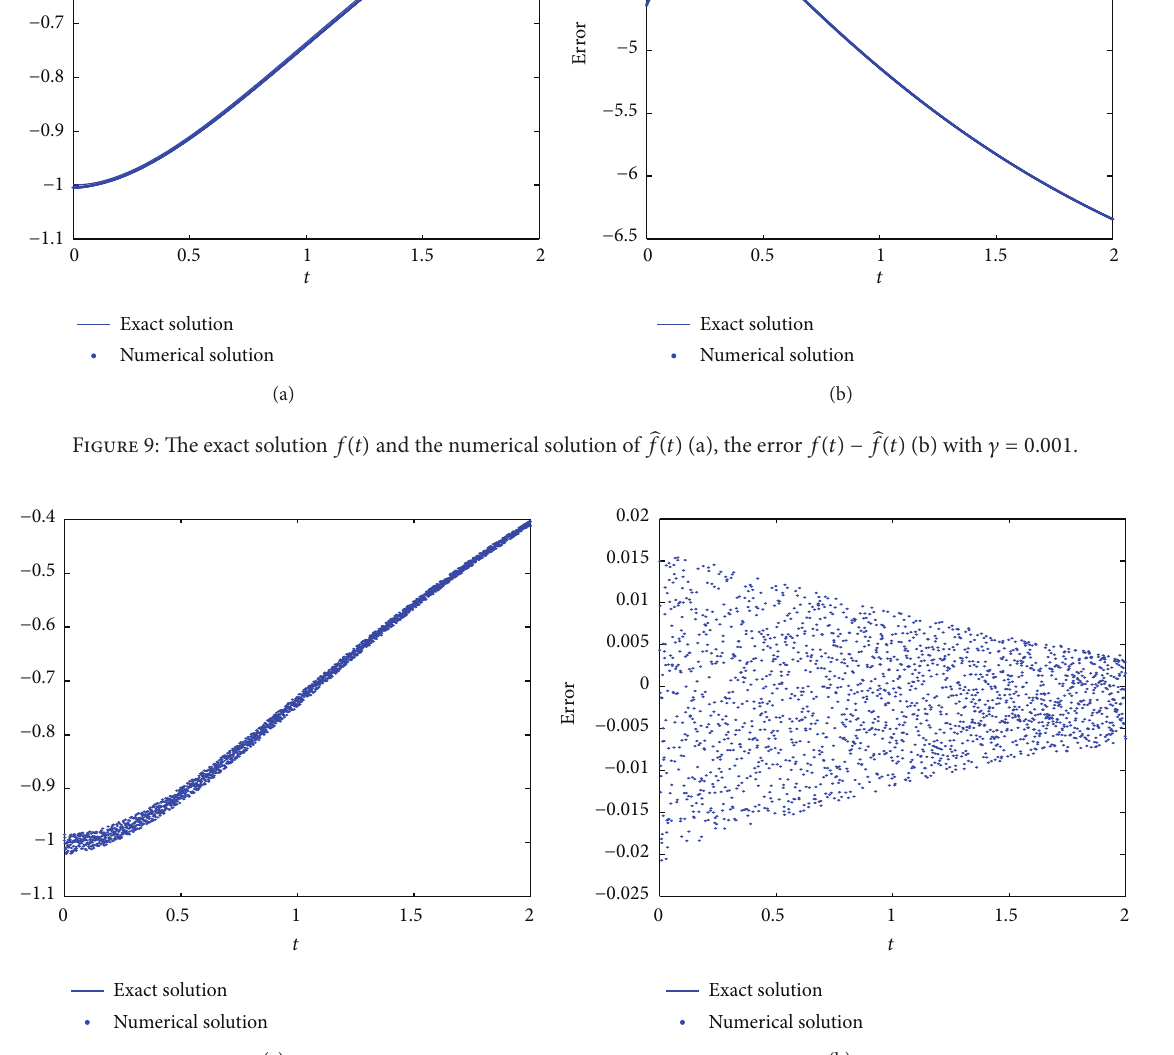
Figure 10: The exact solution 𝑓(𝑡) and the numerical solution of